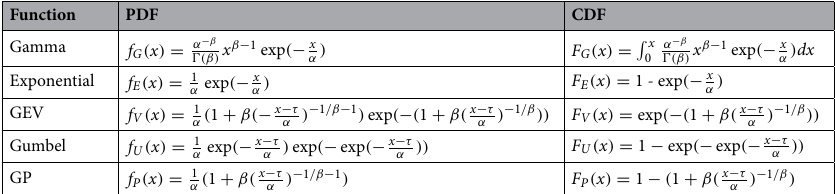
Table 2. PDF and CDF of the functions used in the